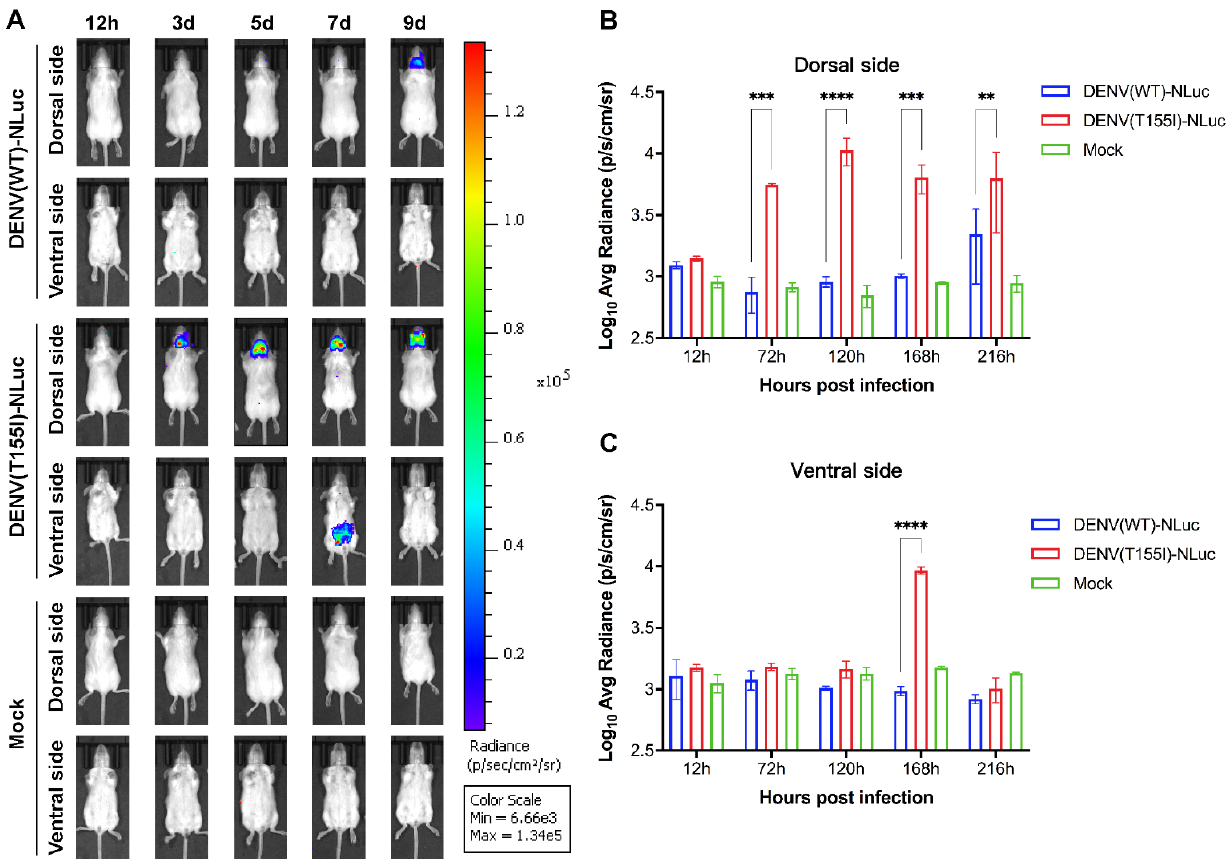
Figure 4. In vivo imaging of reporter DENV intracerebral infection of 4-week-old BALB/c mice. ( A ) BALB/c mice (n = 3) were injected intracerebrally with 4.4 lg PFU of the reporter virus, and fluorescence signals of the dorsal and ventral sides of mice at different time points. A representative animal from each group is shown. ( B ) Average luminescence intensity of the dorsal side of mice at different time points. ( C ) Average luminescence intensity of the ventral side of mice at different time points. Data are derived from two independent experiments. Statistical signi fi cance was determined using two-way ANOVA. **, ***, and **** indicate p ≤ 0.01, 0.001, and 0.0001, respectively, compared with the fluorescence signals in the DENV(WT)-NLuc group.